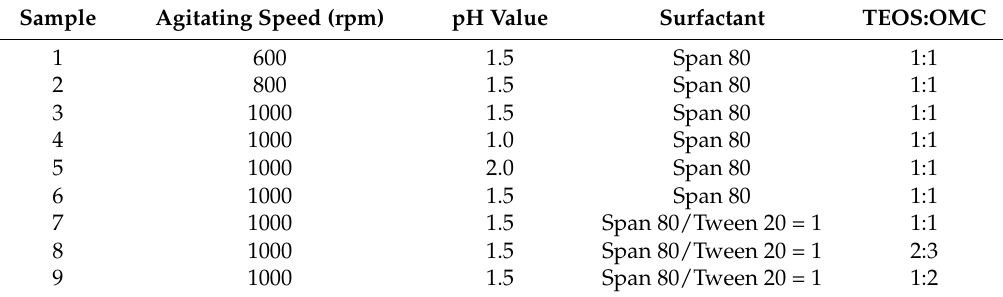
Table 1. Change experimental parameters to the effect of octyl methoxy cinnamates (OMC)/SiO 2 nanoparticles.